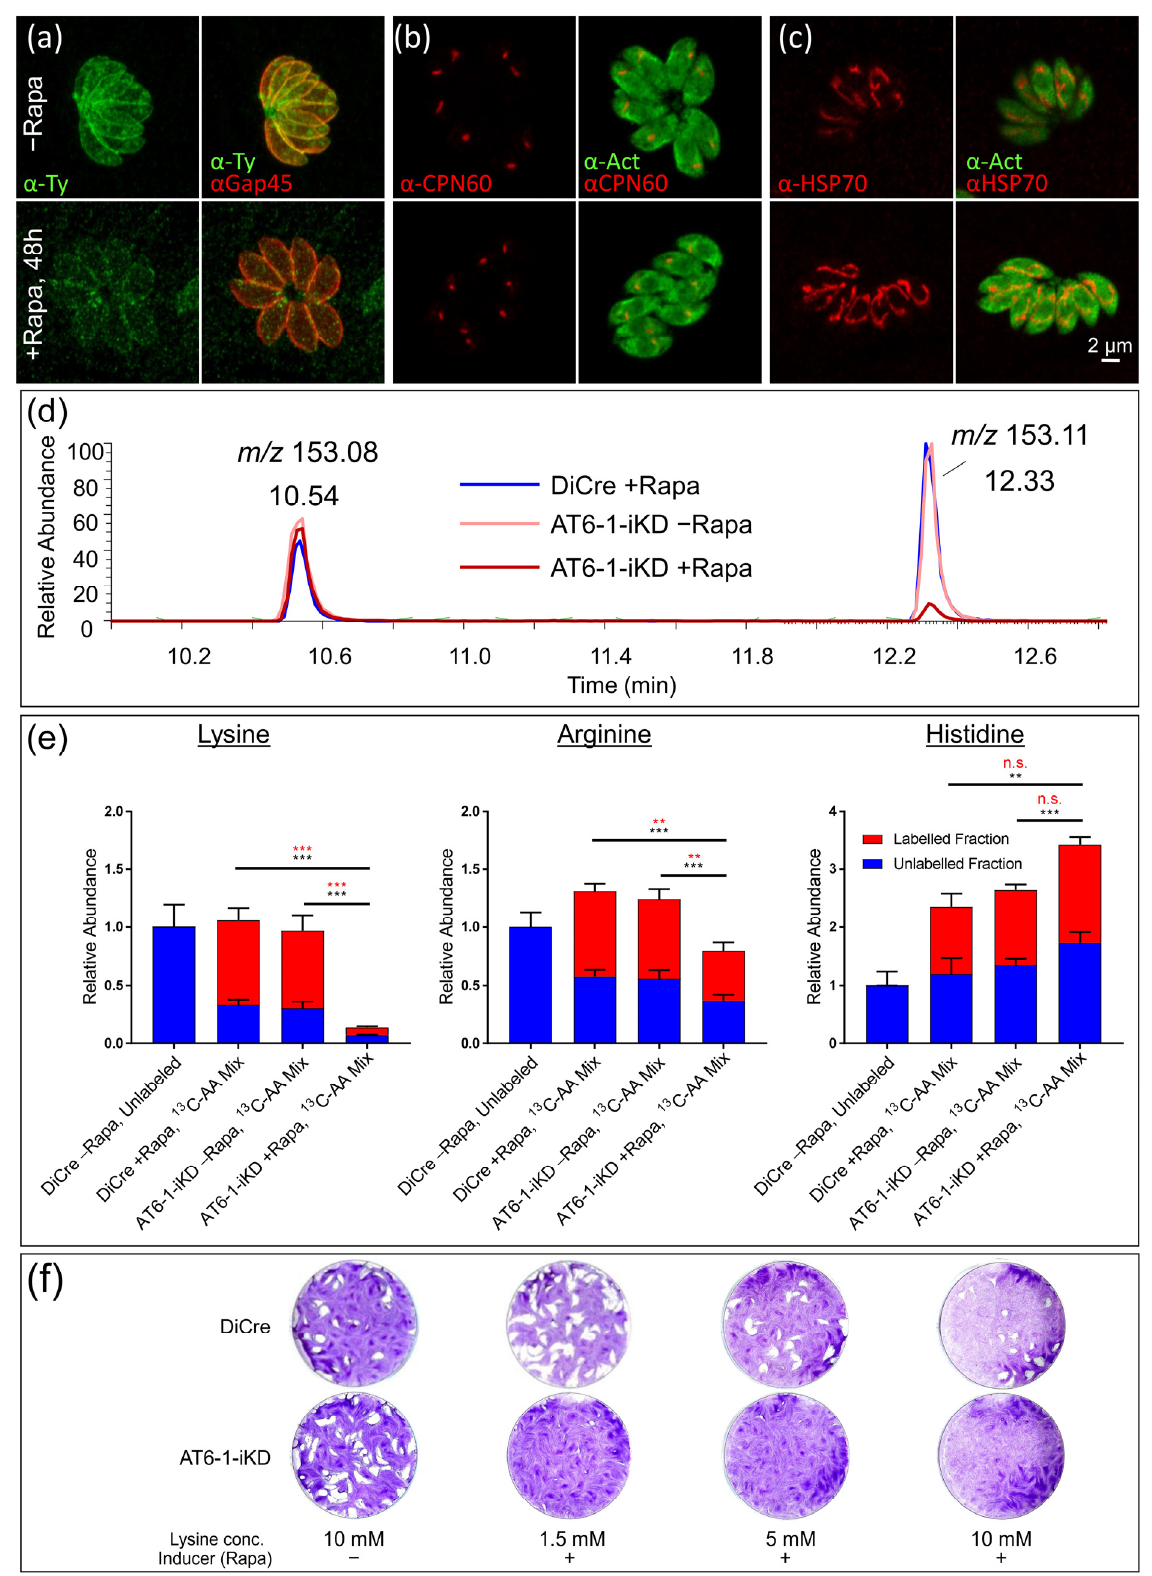
Figure 3. Validation of AT6-1 as the T. gondii lysine transporter. ( a – c ) Immunofluorescence assays (IFAs) of AT6-1-iKD without (top panels) or with rapamycin for 48 h (bottom panels). For antibodies, see top panels and for scale bar, see ( c ). IFA of Ty-tagged AT6-1 (green) and pellicle marker GAP45 (red) ( a ). IFA of apicoplasts (chaperone 60, CPN 60, red) and actin (Act, green) ( b ). IFA of mitochondrion (heat shock protein 70, HSP70, red) and actin (Act, green) ( c ). ( d ) Representative ion chromatogram of parasite extracts. Parasites were treated with rapamycin (+R) or its absence ( − R) for 48 h and